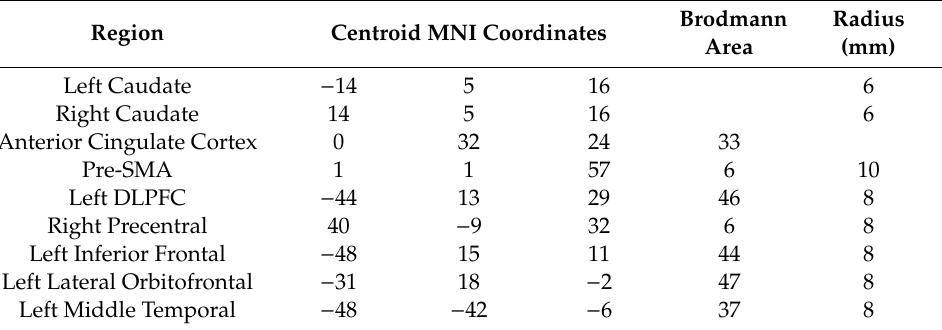
Table 3. Description of interested